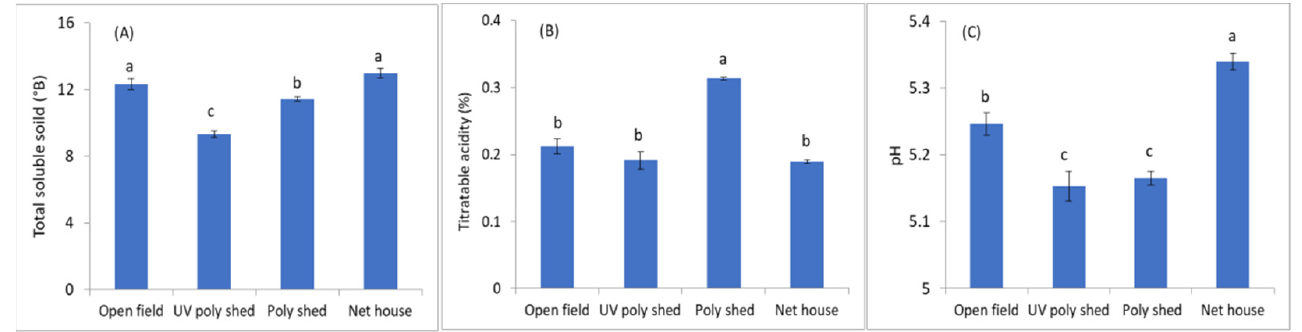
Figure 5. Average content of total soluble solid ( ◦ B) ( A ), titratable acidity (%) ( B ) and pH ( C ) of papaya fruits grown under different sheds and open field condition. Mean ± Standard error (S.E.) (n = 15). Means with the same lower case letter are not significantly different at p = 0.05 by Duncan’s multiple range test.